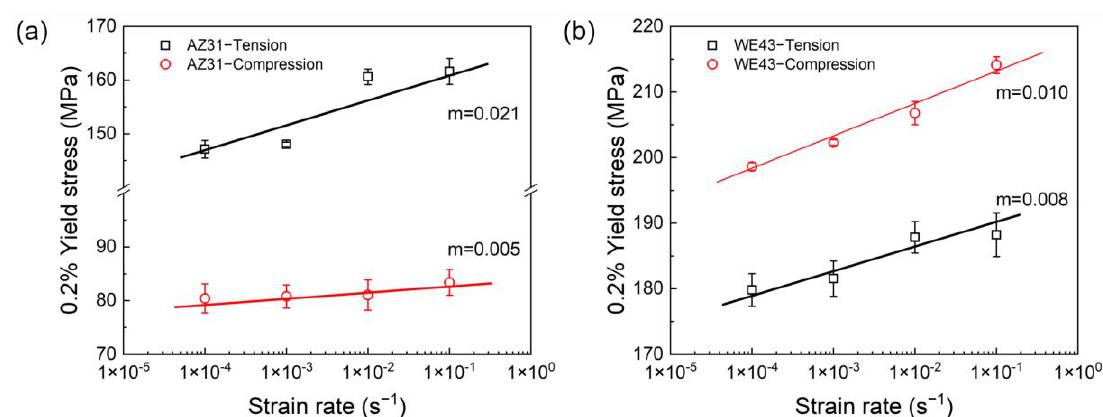
Figure 4. The yield stress (the 0.2% offset) under different strain rates for the ( a ) AZ31 and ( b ) WE43 alloy under uniaxial tension and compression: ( a ) The SRS factor of the AZ31 alloy under tension was 0.021 on the yield stress but only 0.005 under compression deformation. It exhibited obvious tension–compression asymmetry, which is attributed to the presence of tension twinning during the early stage of deformation. ( b ) The SRS factor of the WE43 alloy under the same conditions were 0.008 and 0.010 for both tension and compression, respectively, revealing that the SRS was hardly influenced by the loading direction.